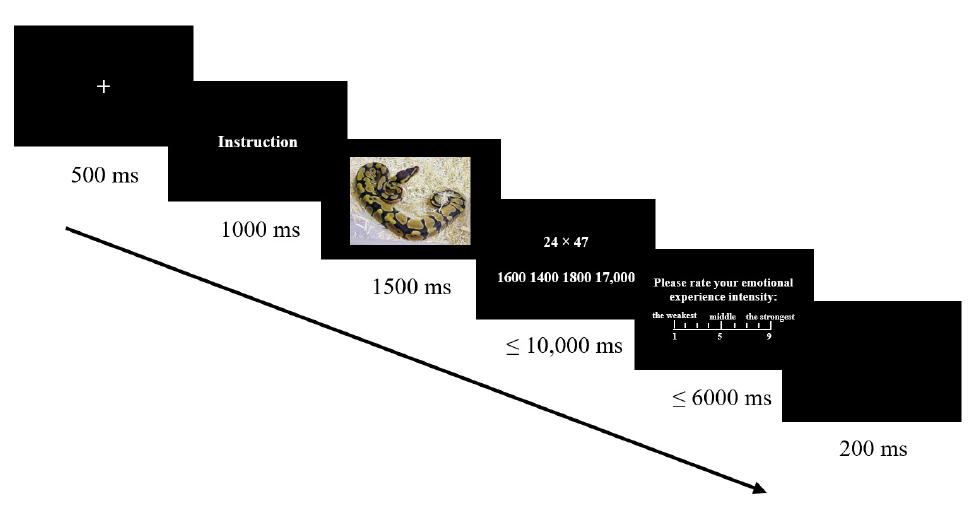
Figure 2. Flow chart of experiment